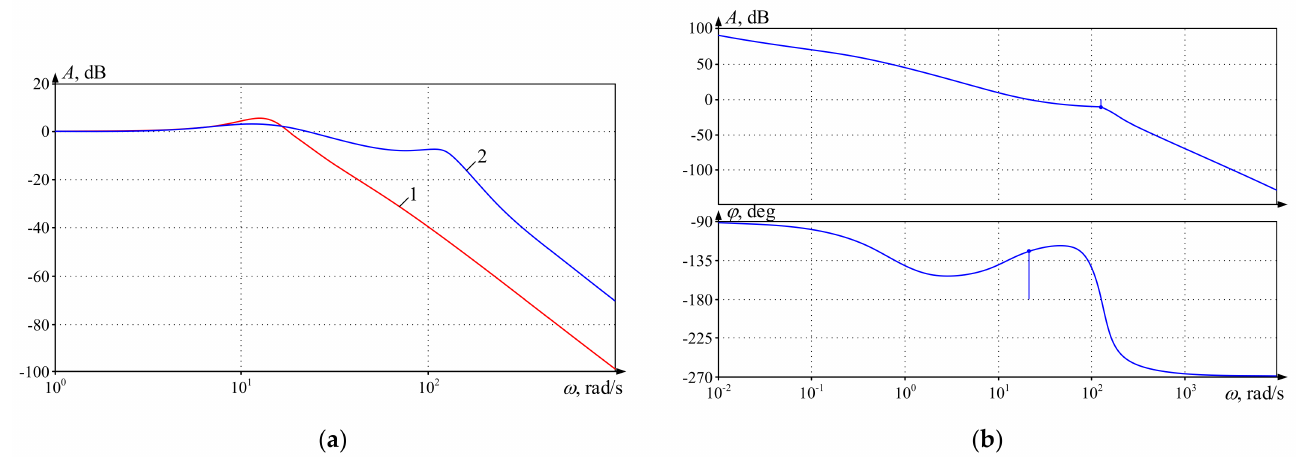
Figure 13. Bode magnitude plots of the closed speed control loops ( a ), Bode magnitude and phase plots with an open external loop ( b